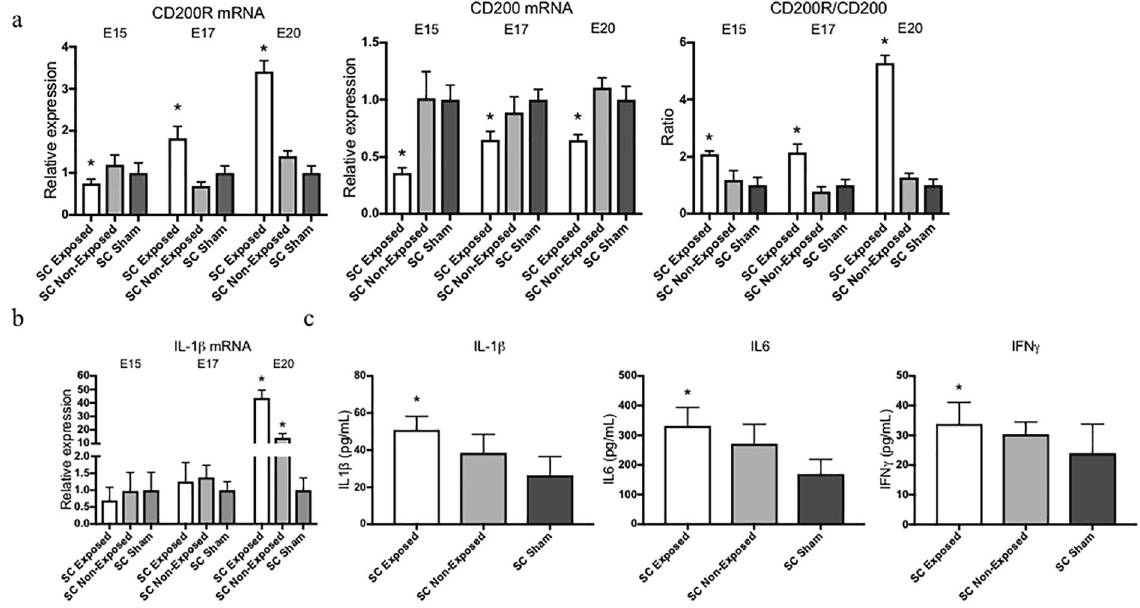
Figure 7. Progressive disruption of immune ligand-receptor (CD200-CD200R) in spina bifida aperta. ( a ) Comparison of CD200R, CD200, and CD200/CD200R ratio relative expression in exposed neural tissue, unexposed, and sham animals at different gestational age (E15, E17 and E20). Means ± SE (n = 6 fetuses/group) of relative expression (2 − ΔΔ Ct) for RA-treated and time-matched controls; ( * p < 0.05). ( b ) IL1 β gene relative expression confirmed the upregulation and correlation between microglial activation, neuroinflammation, and cytokine production in exposed spina bifida spinal cord at E20 of gestation. ( c ) Cytokine (IL1 β , IL6, INF γ ) protein expression by Luminex exhibit higher cytokine expression in the exposed spinal cord of spina bifida compared with unexposed or sham rats (n = 5 fetuses/group) at E20. Values are means ± SD ( * p <